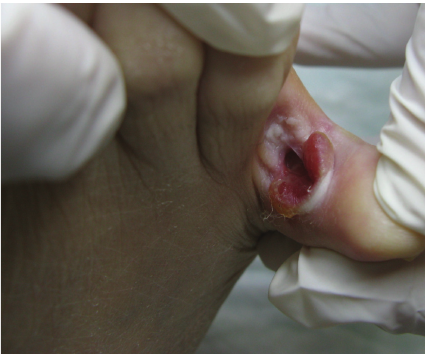
Figure 1: A deep ulcer located on the fourth intertoe space of the right foot.